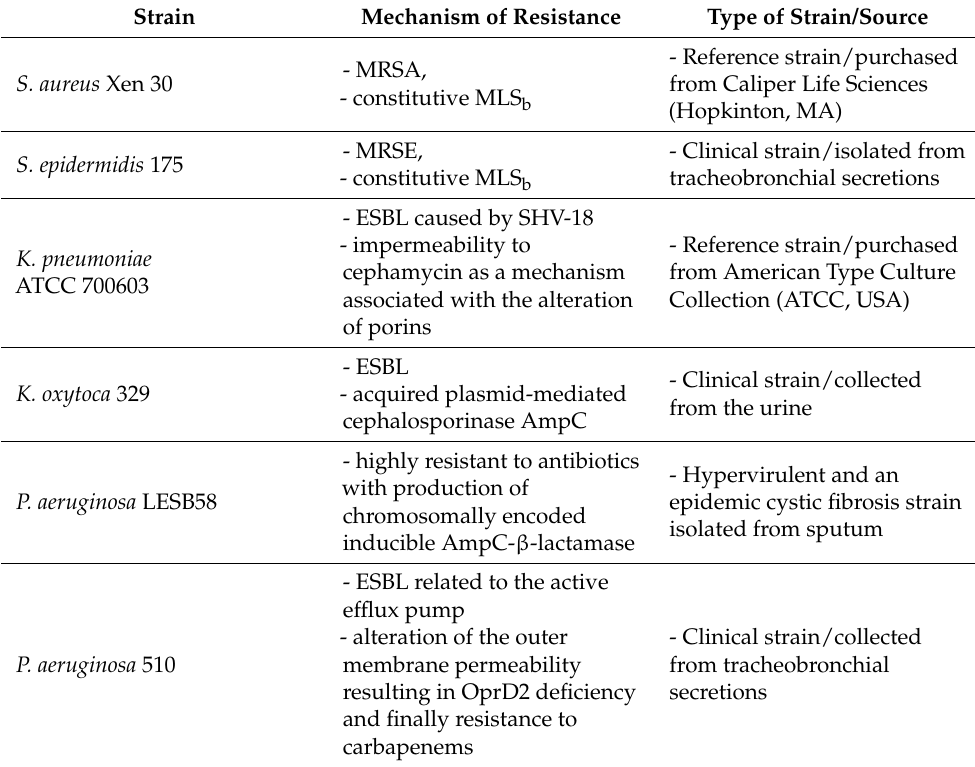
Table 1. The characteristics of the examined bacterial